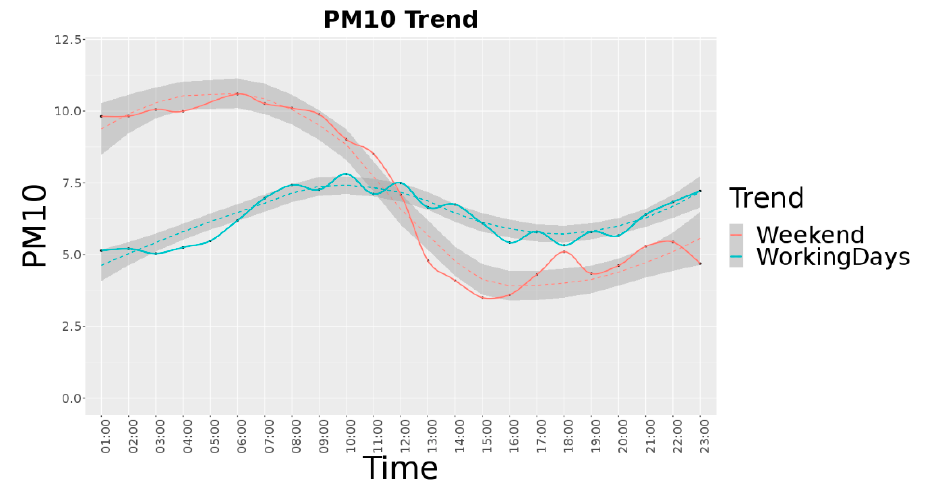
Figure 3. Helsinki Jätkäsaari 𝑃𝑀 (cid:2869)(cid:2868) average trend for weekend and working days per hour.